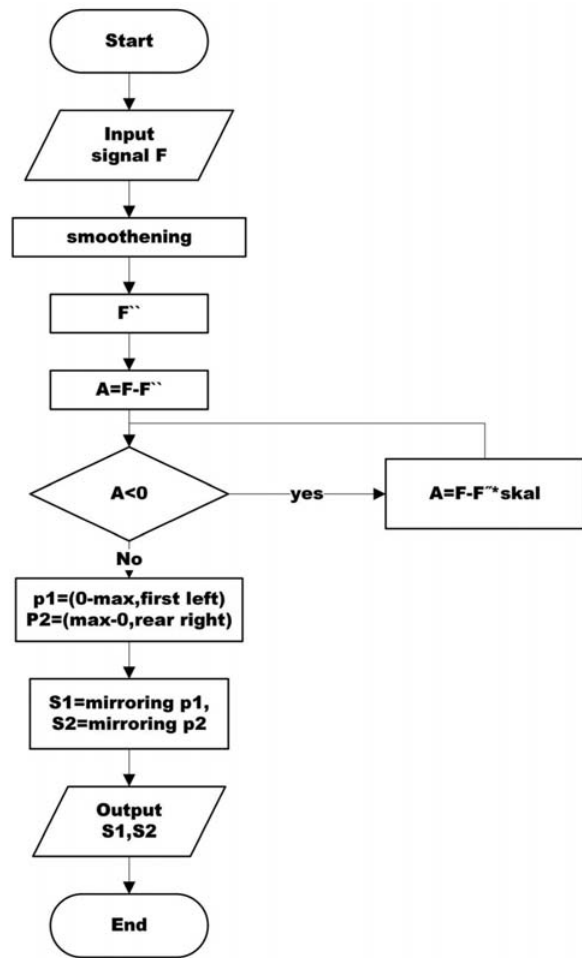
Figure 2. Flow chart of the